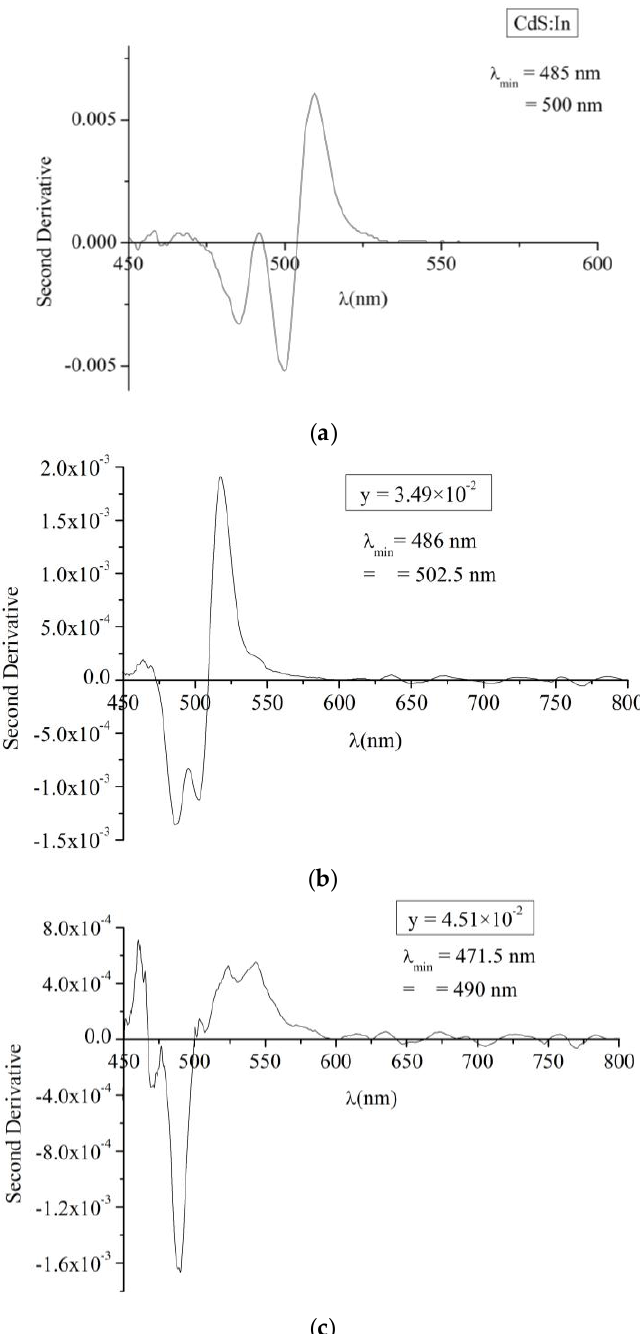
Figure 7. Cont. Figure 7.